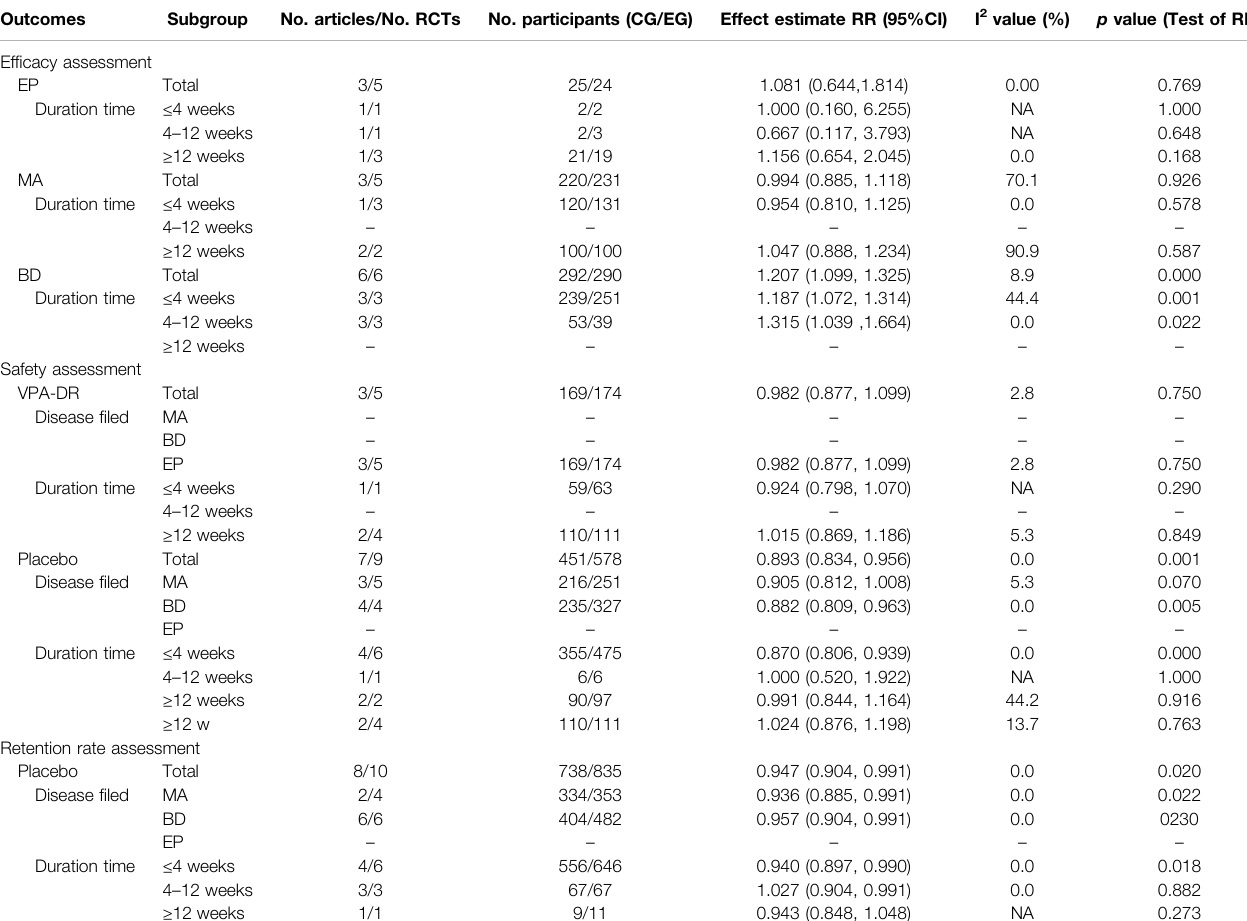
TABLE 7 | Subgroup analysis of